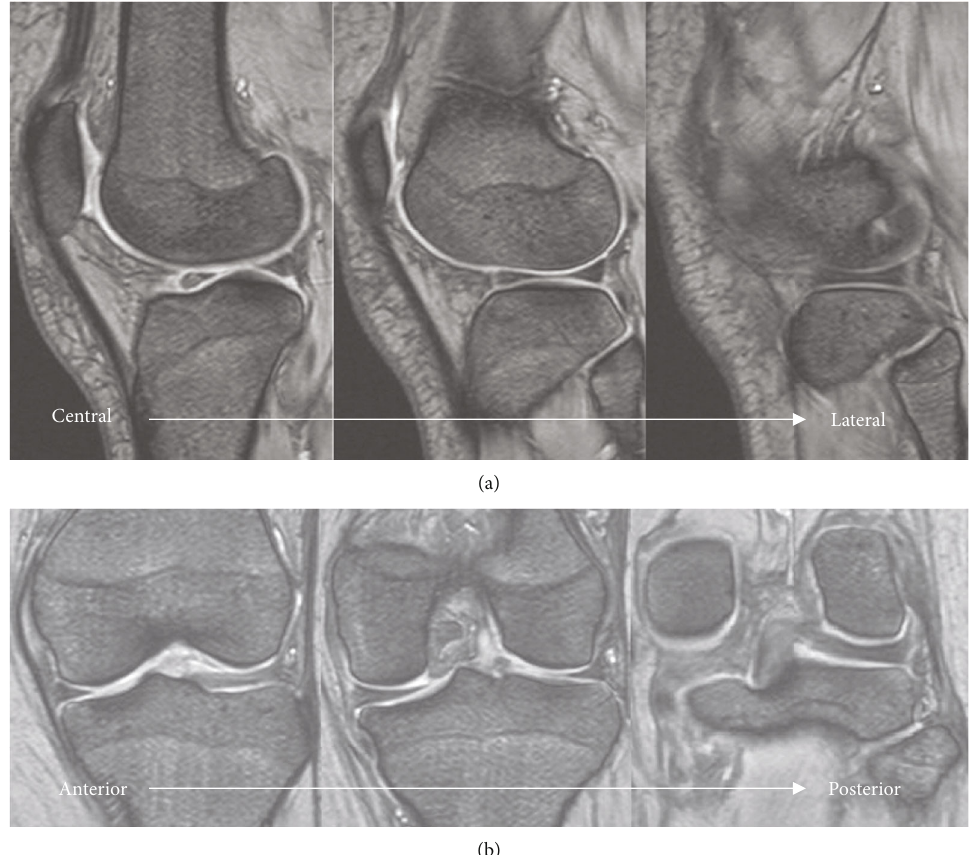
Figure 2: Preoperative MRI. Preoperative MRI showed no abnormal intensity at the meniscus. (a) T2 ∗ sagittal; (b) T2 ∗ coronal. MRI: magnetic resonance imaging.